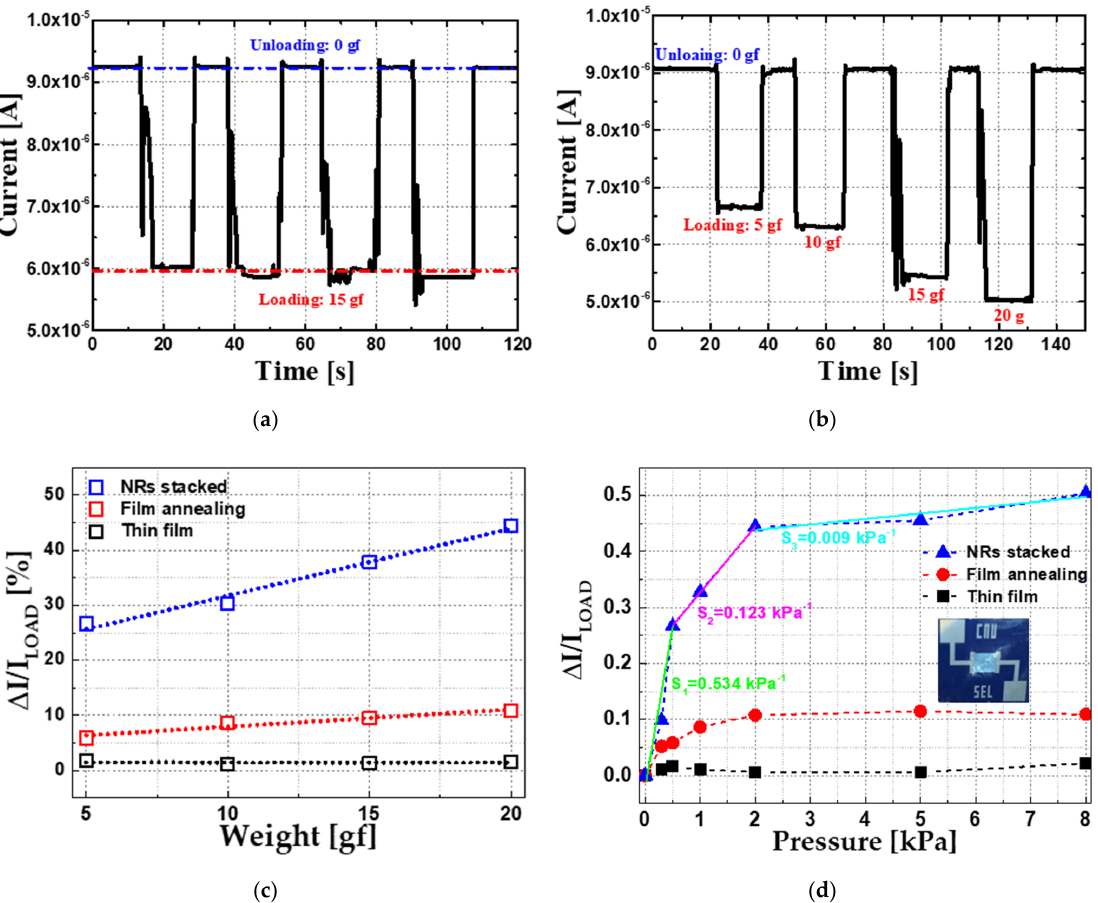
Figure 4. Pressure test results of fabricated devices; ( a ) NRs stability test. 15 g loading results after 200 cycles of NRs stacked type; ( b ) Time dependent current result of NRs stacked type. The amount of change in current was measured by repeatedly raising and lowering an object of 5~20 g; ( c ) Weight dependent current ratio result in a small range (5~20 g); ( d ) Sensitivity measurement up to 8 kPa. ( 𝑆 1 : 0~ 0.5 kPa, 𝑆 2 : 0.5~2 kPa 𝑆 3 :2~8 kPa). Inset is pressure sensor device with a wide sens- ing area for various weight measurements. area for various weight